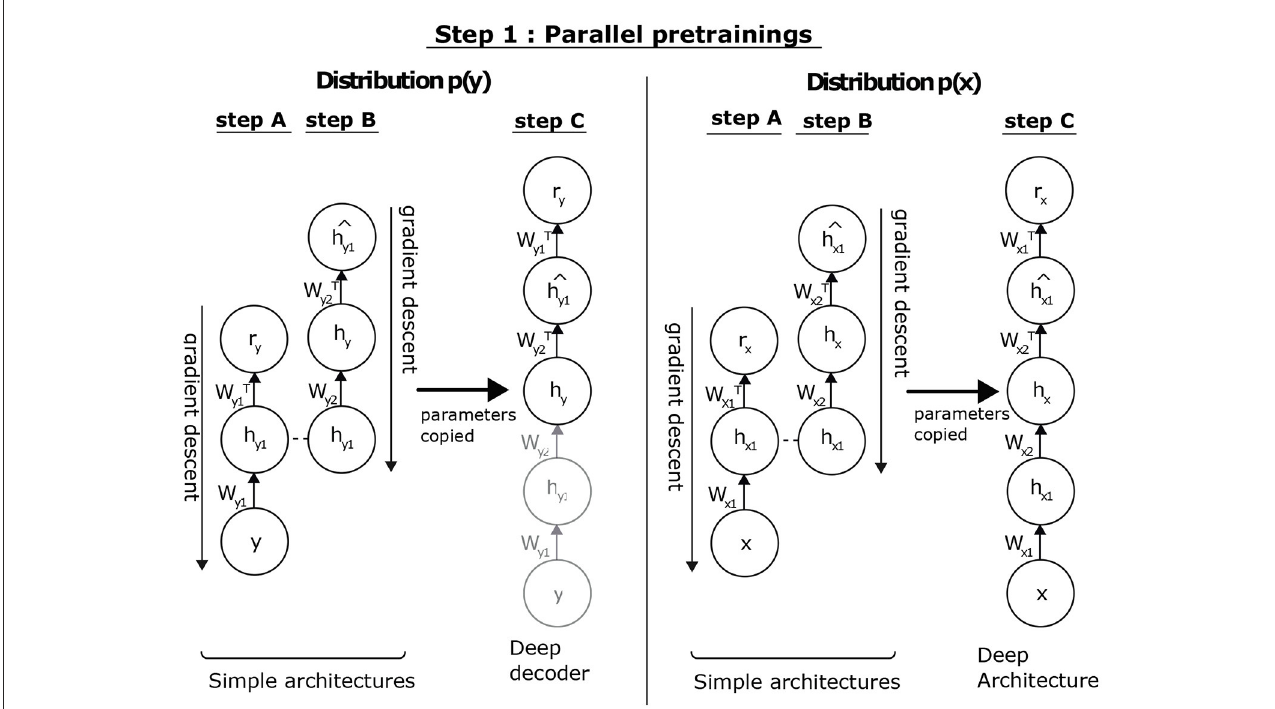
FIGURE3 Parallel pre-training step. Concerning p ( x ), we aim at initializing the parameters associated to p encoder ( h x | x ) and p decoder ( x | h x ). To do so, we have previously shown that it is possible to apply the unsupervised pre-training algorithm. Concerning p ( y ), it is the parameters associated with p decoder ( y | h y ) that we seek to initialize in a consistent manner. To this end, we consider defining a deep AE of the same dimension, whose goal is to extract the h y representation of the data y . Reasoning by analogy, the unsupervised pre-training of this model is sufficient to obtain the values values. This approach allows us to initialize the two sub-architectures associated to p ( x ) and p ( y ). By inference, we can then deduce the distributions p encoder ( h x | x ) and p encoder ( h y | y